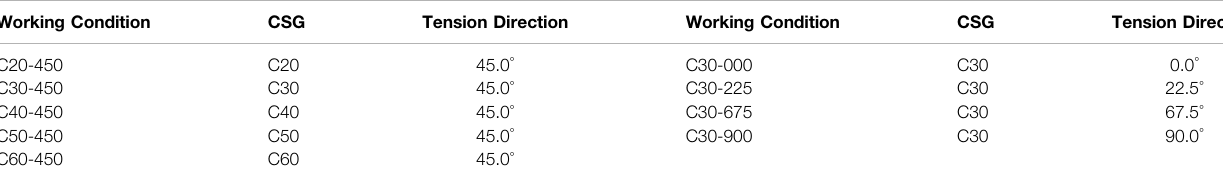
TABLE 7 | Working condition parameters.